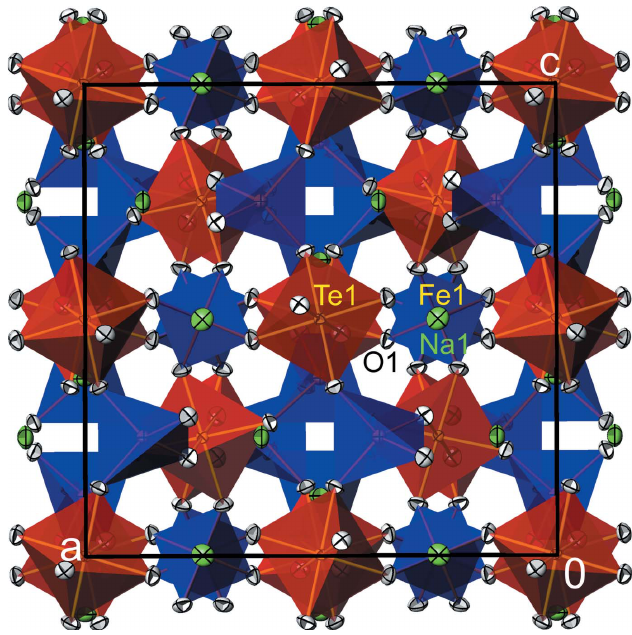
Figure 1 Projection of the garnet-type crystal structure of Na 3 Te 2 (FeO 4 ) 3 along [010]. Displacement ellipsoids are drawn at the 90% probability level. [TeO 6 ] octahedra (red) and (FeO 4 ) tetrahedra (blue) are given in the polyhedral representation, Na atoms as green ellipsoids and O atoms as white